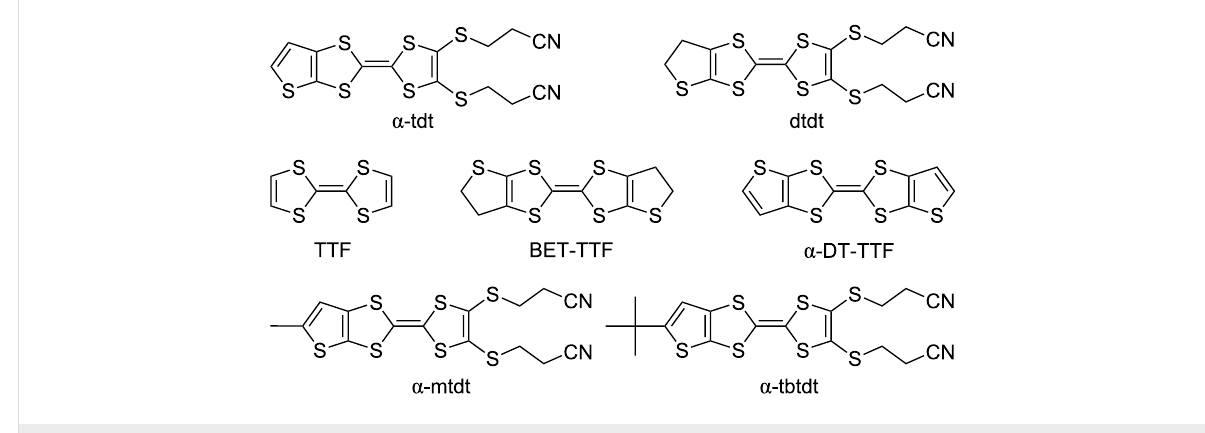
Scheme 1: Molecular diagrams of α -tbtdt ( 1 ) and α -mtdt ( 2 ), and related TTF-type donors.